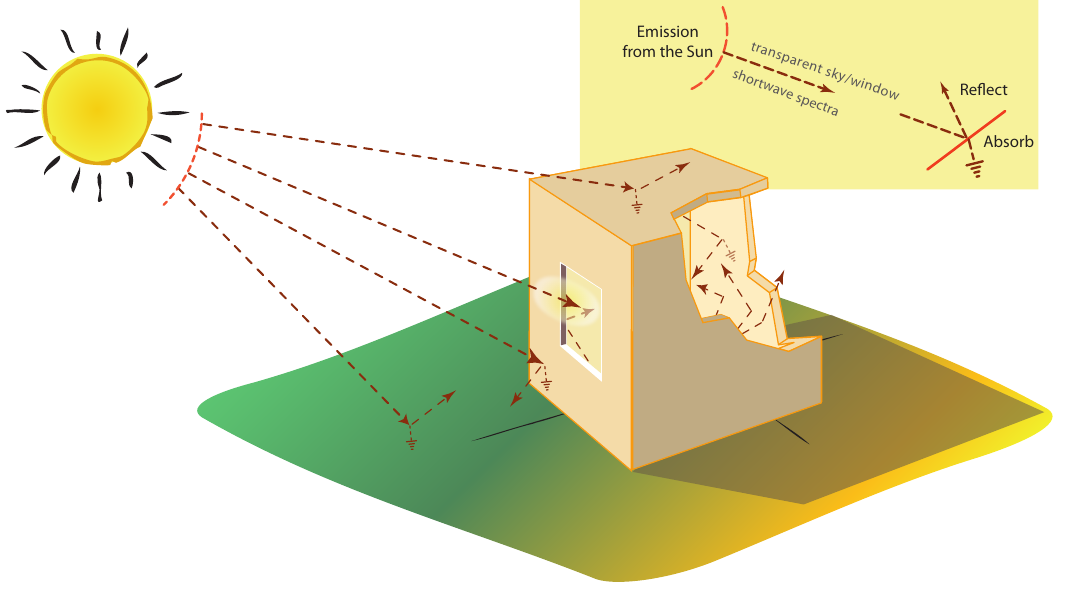
Table 1. Technologies for solar energy conversion systems related to